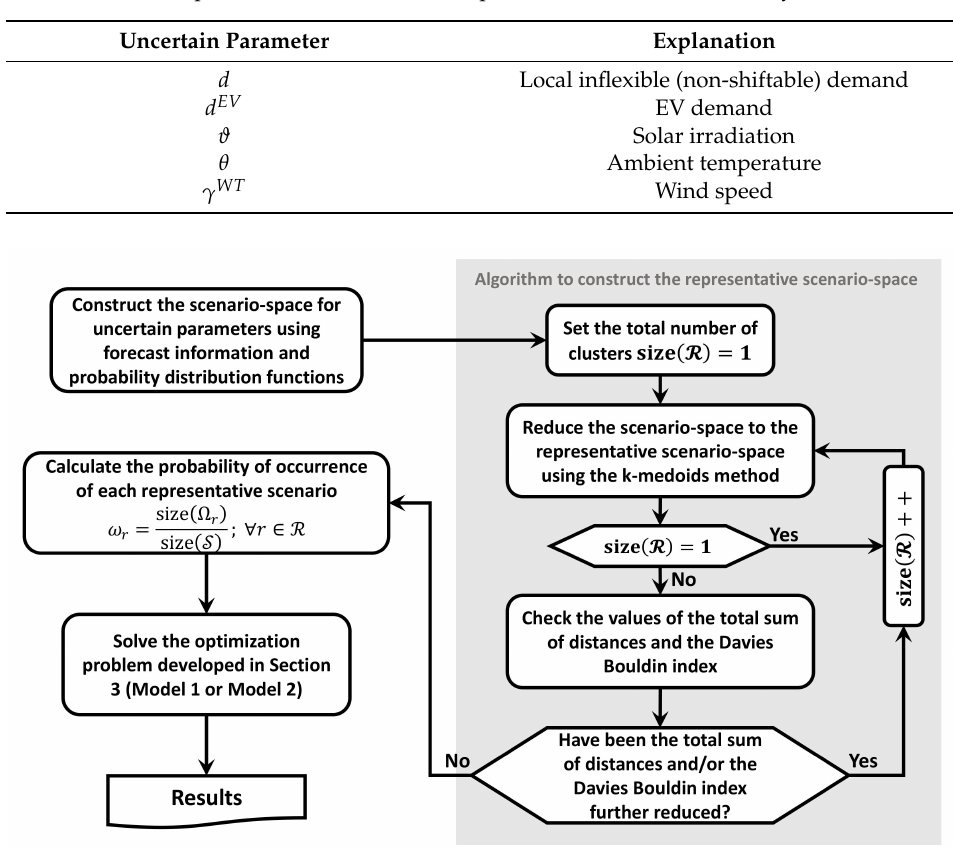
Table 1. Uncertain parameters involved in the operation of the NG under study.